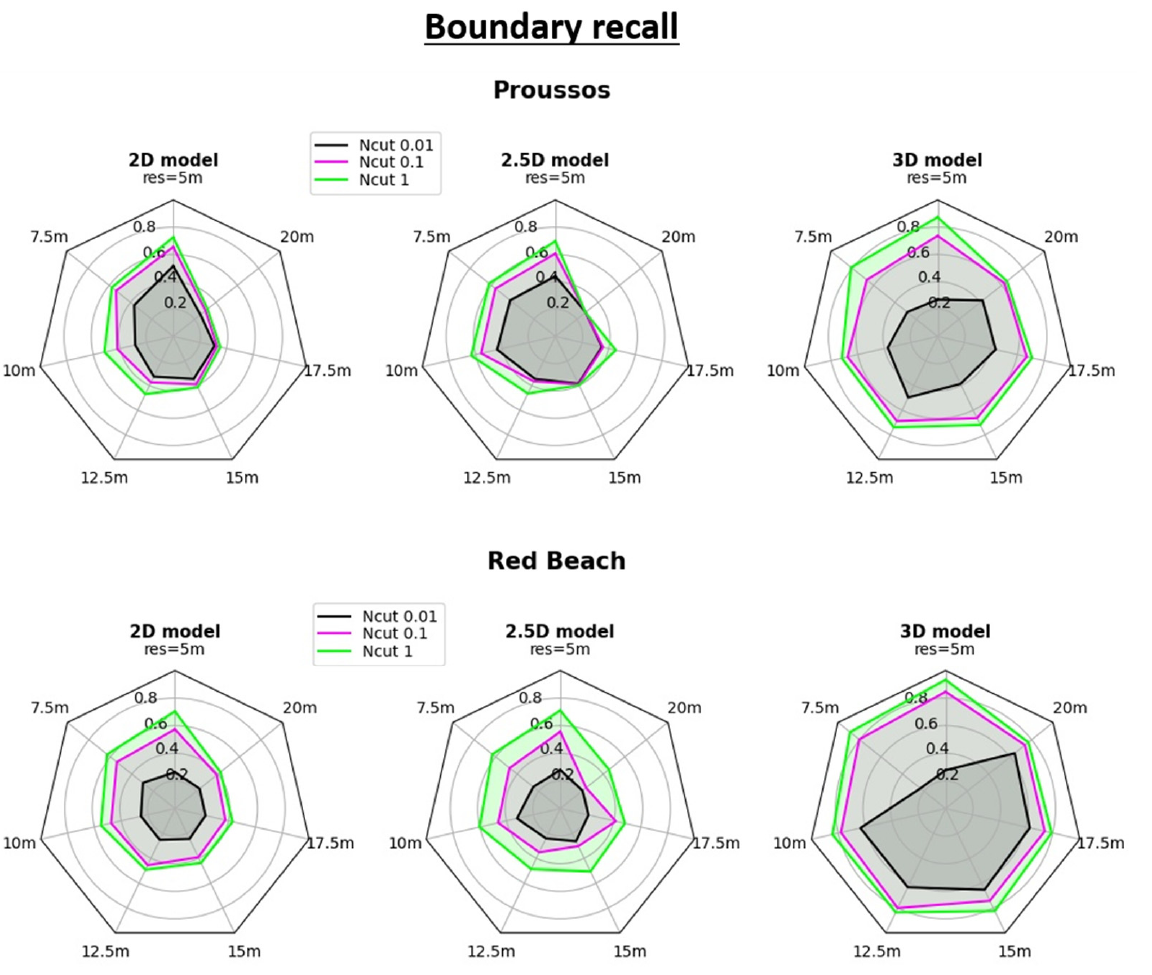
Figure 10. The boundary recall of the superpixel/supervoxel-based graph-based segmentation for each dimensionality of the UAV-derived input digital models.